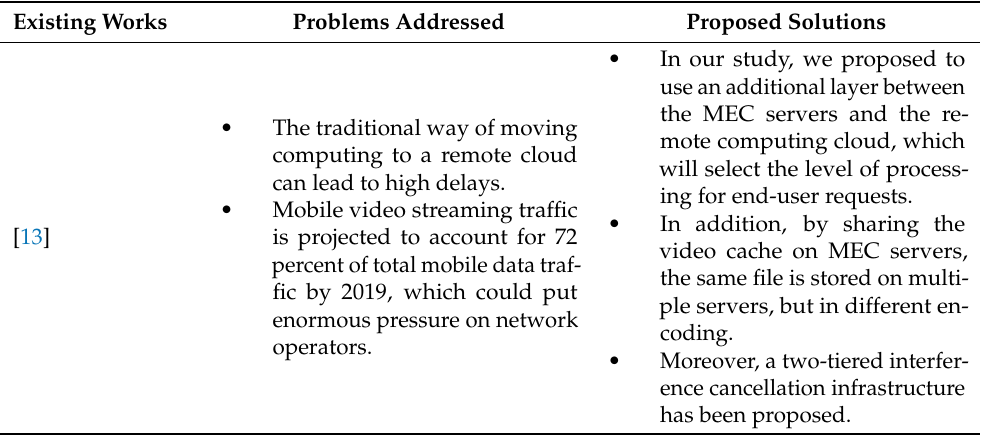
Table 1. Related